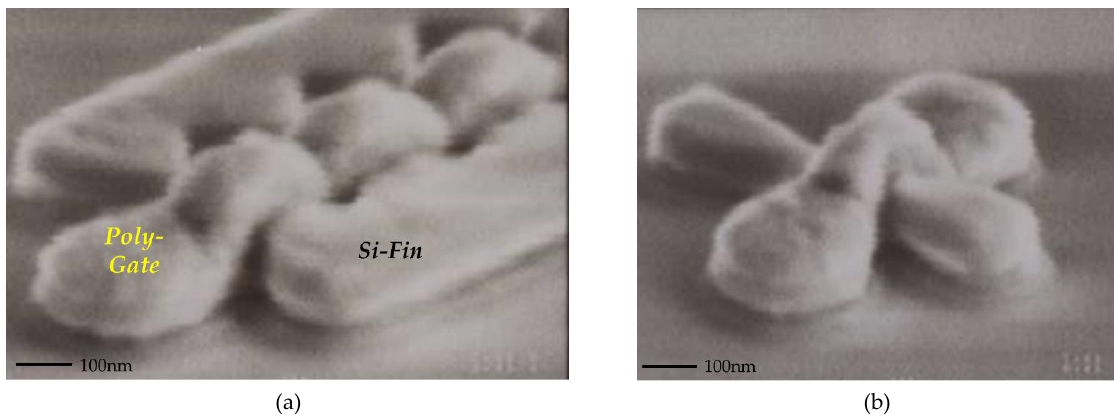
Figure 6. Top-view of SEM photos: ( a ) multi Si-fin and ( b ) single Si-fin.